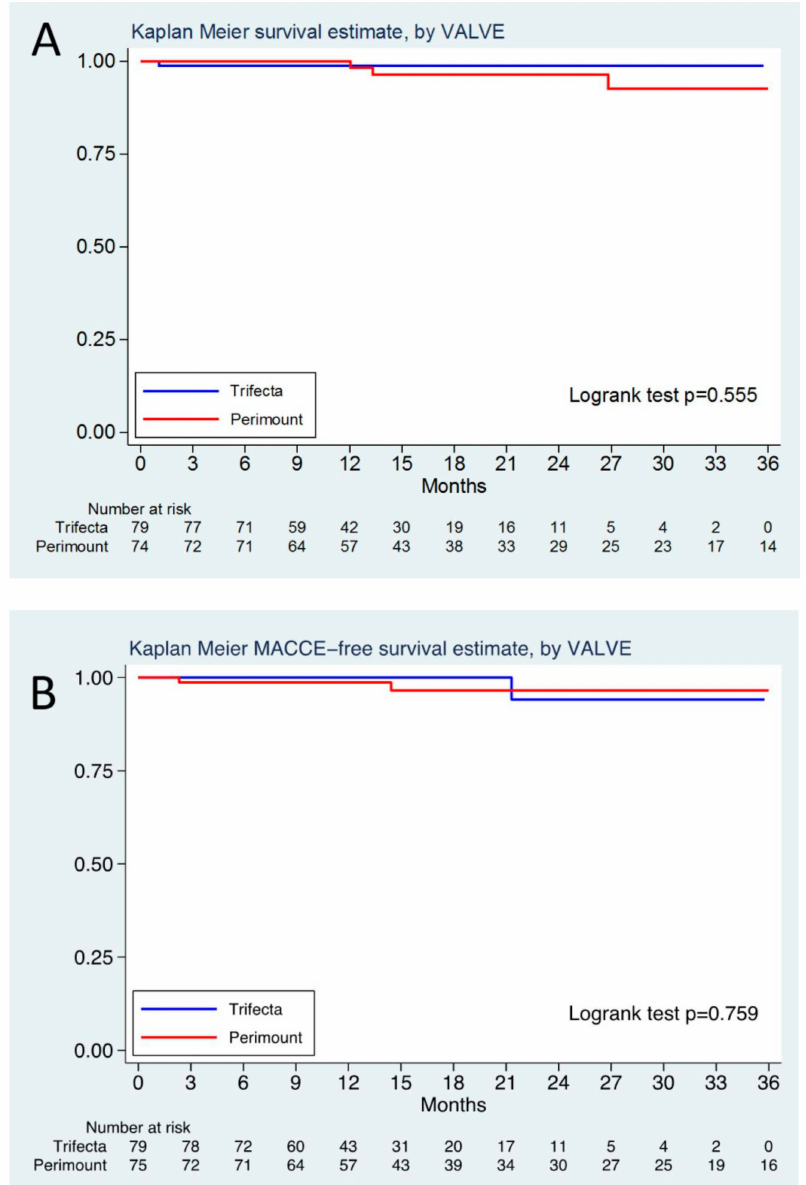
Figure 2. ( A ) Cumulative Kaplan–Meier survival curves. ( B ) Cumulative Kaplan–Meier MACCE- free survival curves. Given the very low number of events, we only present the Kaplan–Meier curves from the unweighted